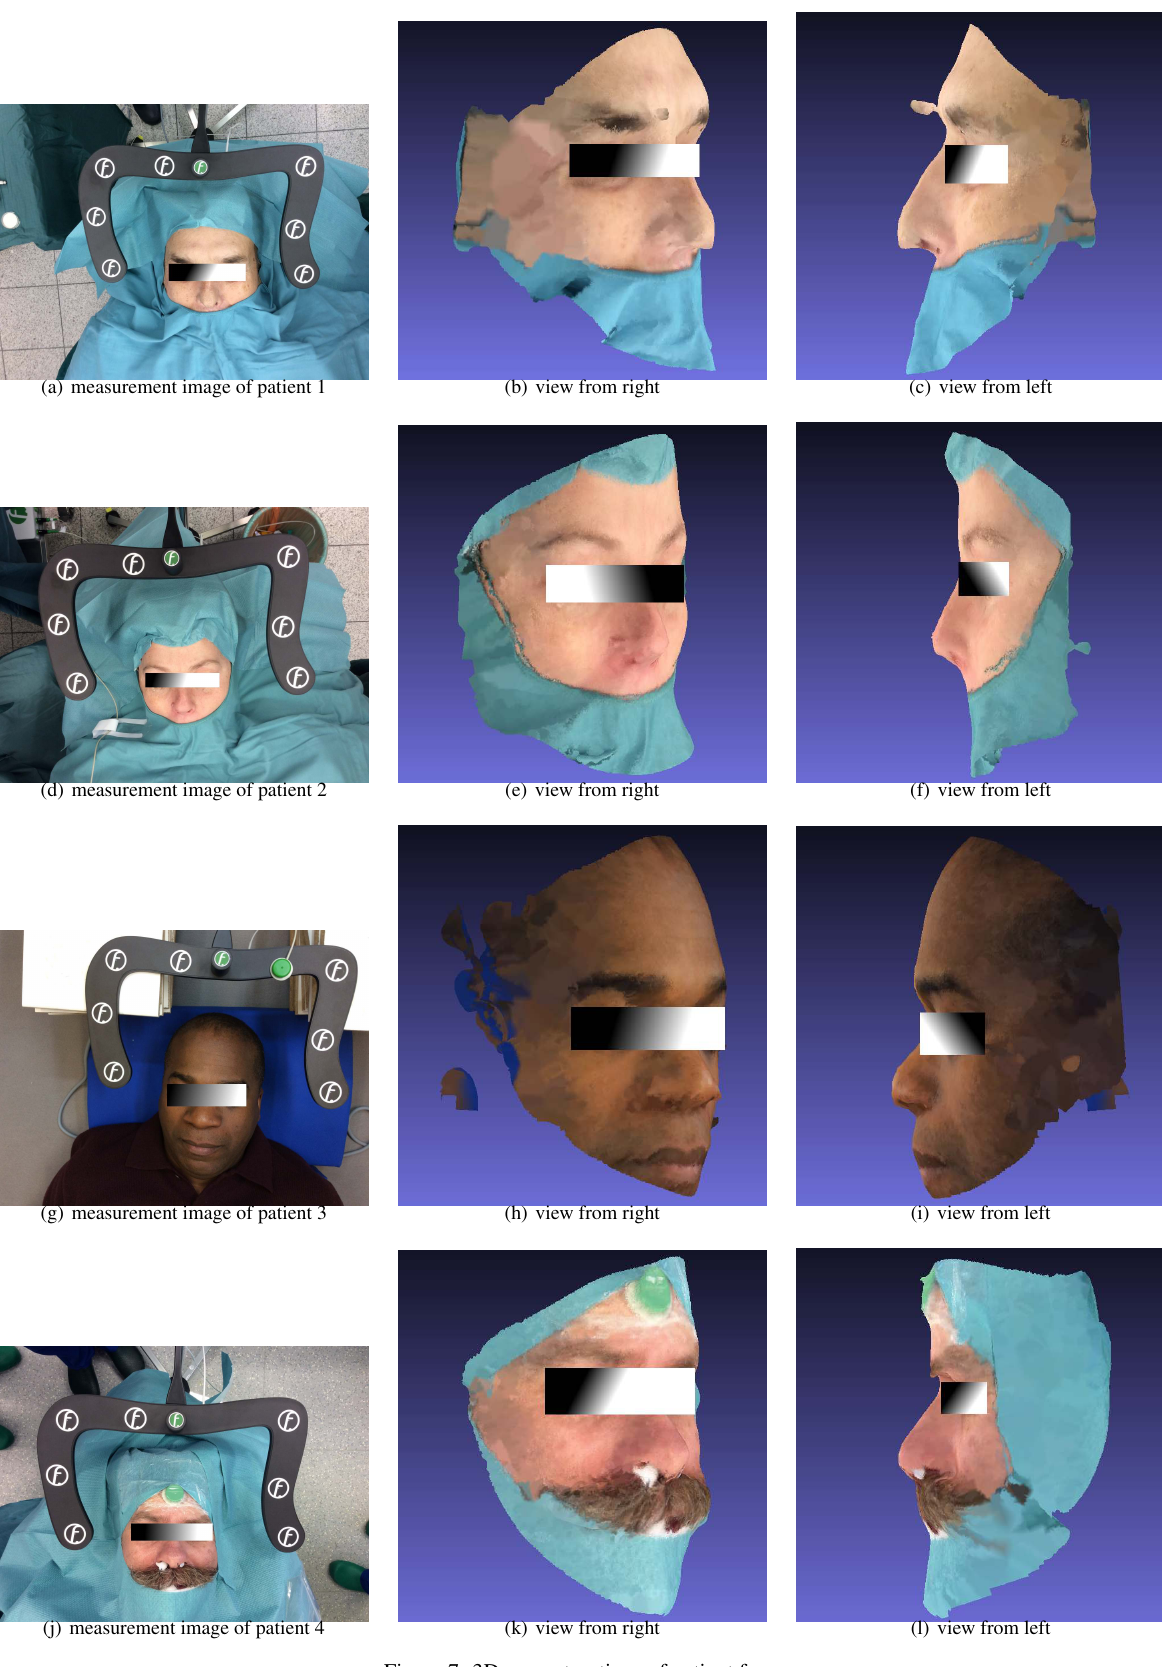
Figure 7: 3D reconstructions of patient